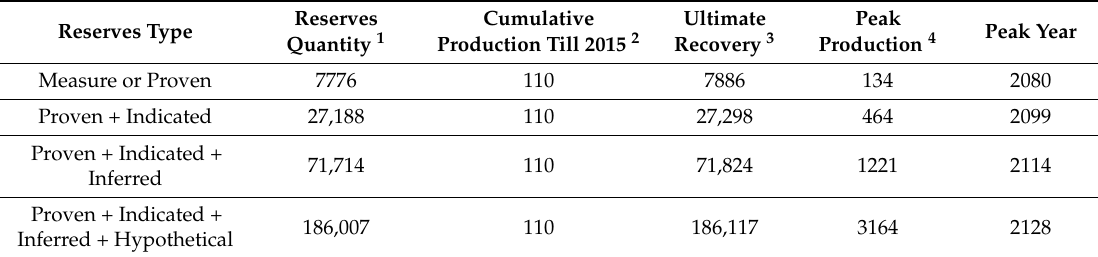
Table 4. Hubbert production peak of Coal under various assumptions of reserves